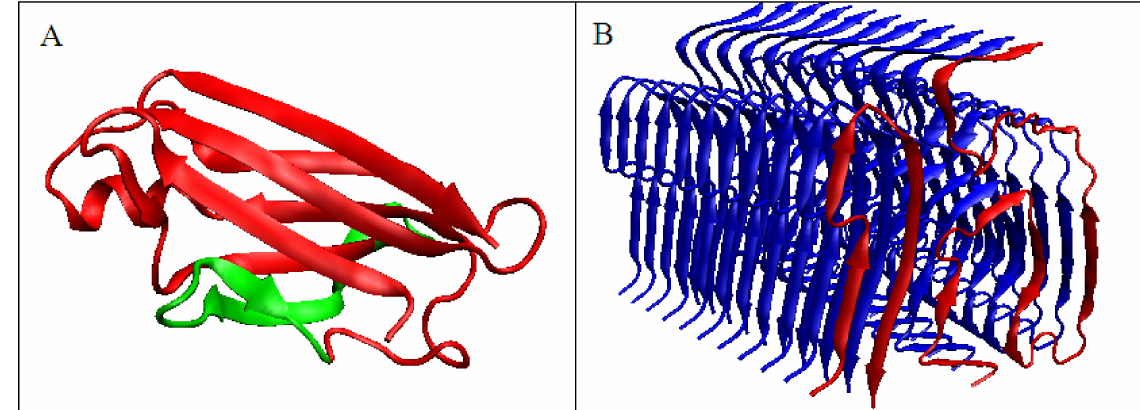
Figure 3. 3D presentation of transthyretin chain. ( A )—Native form, the red fragment present in amyloid form, green fragment, absent in amyloid form ( B )—red chain, amyloid form – analog to red fragment in A.